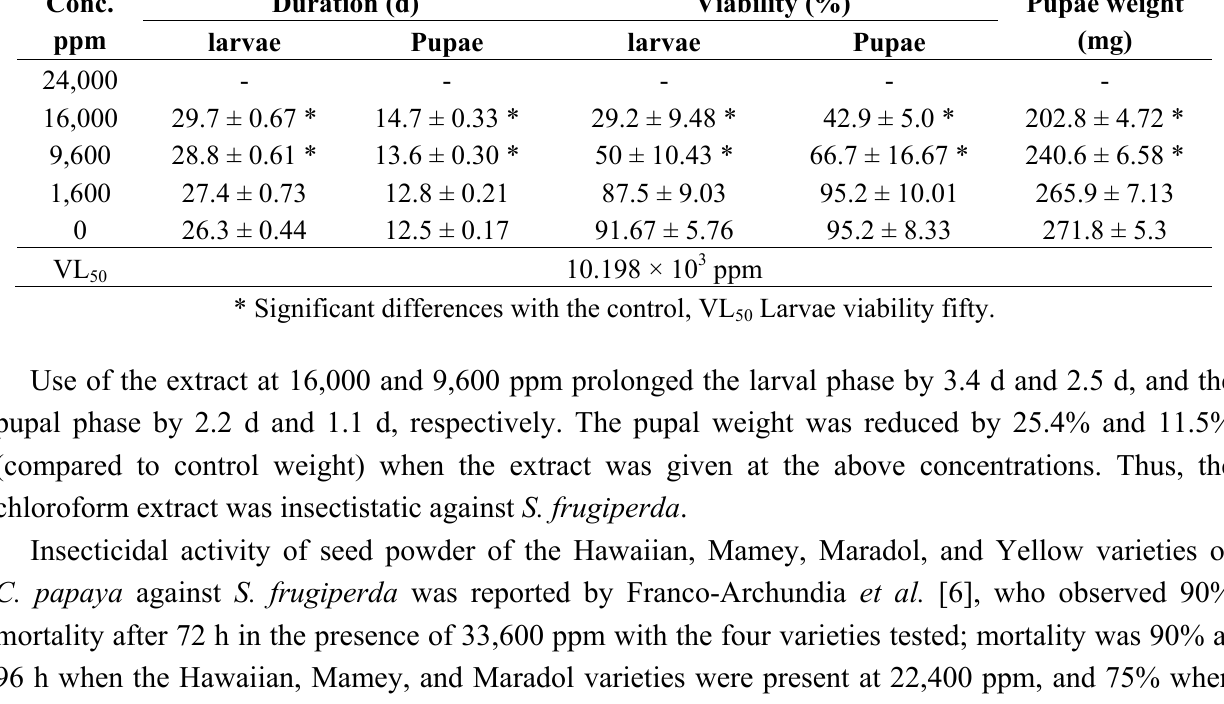
Table 2. Mean (±SE) larvae and pupae duration, larvae and pupae viability and weight of S. frugiperda with chloroform extract of the seeds of C. papaya seeds.